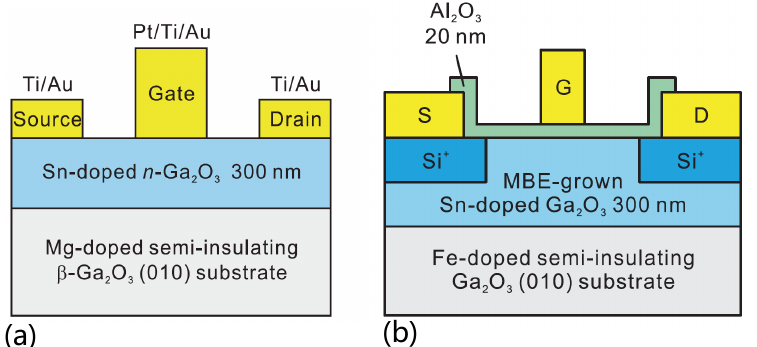
Figure 8. Device diagram of ( a ) β -Ga 2 O 3 FET and ( b ) β -Ga 2 O 3 MOSFET with Al 2 O 3 gate dielectric. Reprinted from [114] and [115], with the permission of AIP Publishing.